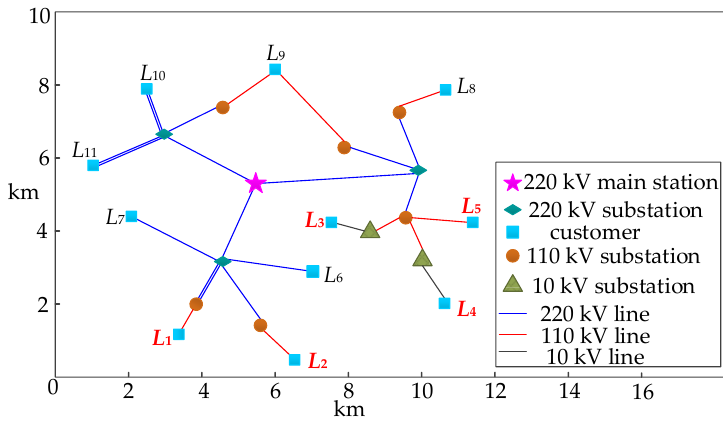
Figure 7. Internal network model.